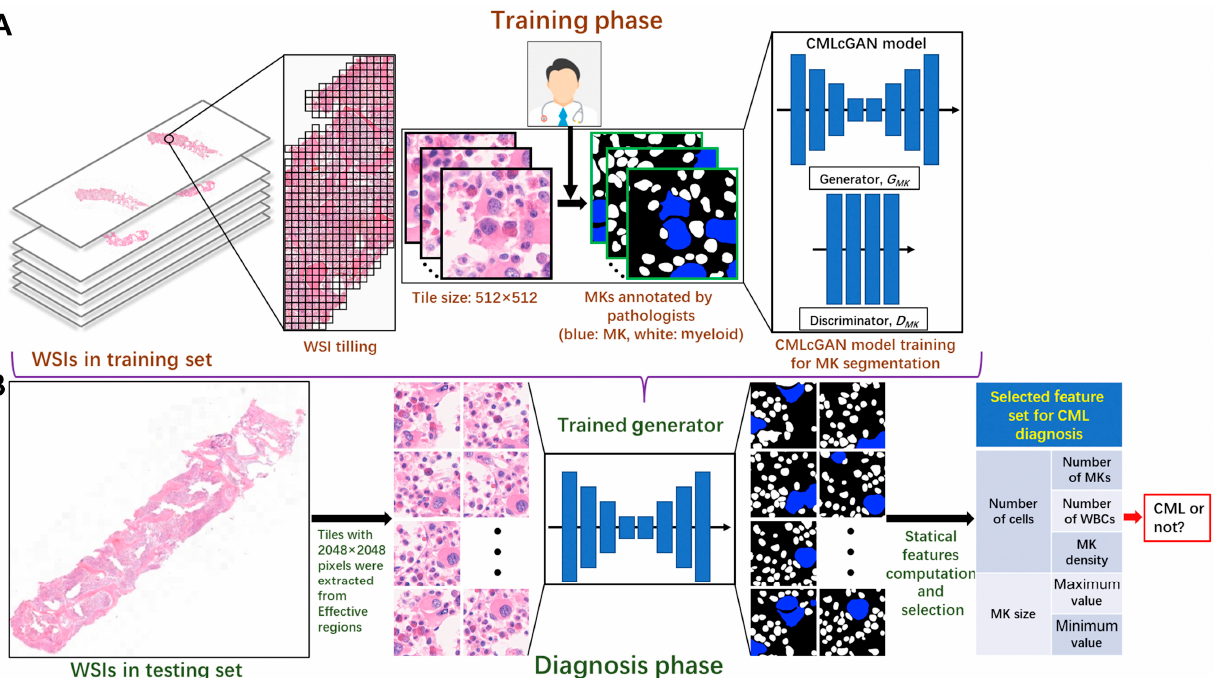
Figure 5. The framework of the automatic diagnosis of chronic myeloid leukemia (CML). ( A ) The CML conditional generative adversarial network (CMLcGAN) training. ( B ) The pipeline of the whole diagnostic process “Reproduced with permission from Zhang et al., The American Journal of Pathology; published by Elsevier, 2022” [29] .